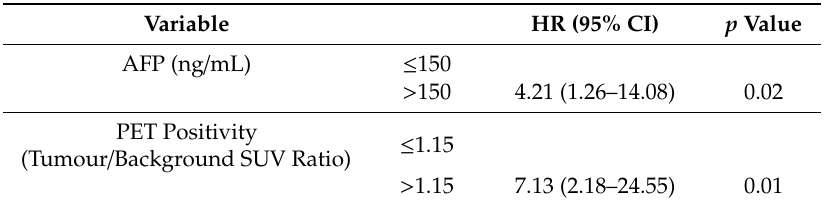
Table 2. Multivariate analysis of risk factors for recurrence-free survival.